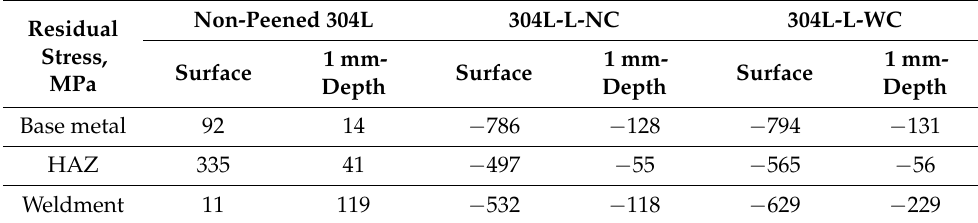
Table 8. Residual stress on the surface and at 1 mm depth of 304L stainless steel. Residual Stress,